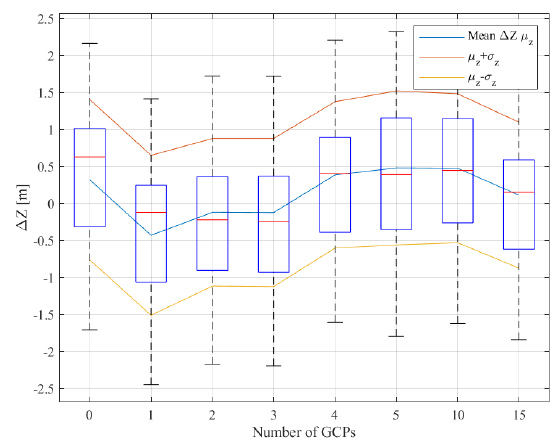
Figure 7 – Elevation model accuracy: trend of  Z (17 CPs) vs number of